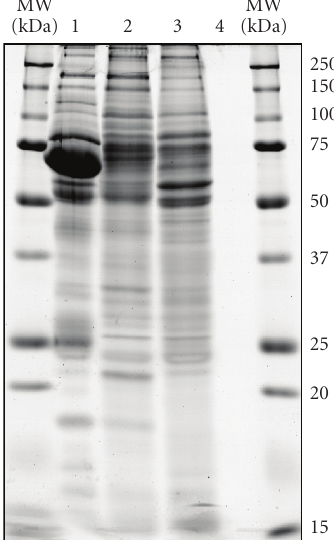
Figure 4: 1DGE analysis of human blood plasma before and after prefractionation using immunoa ffi nity depletion of high-abundant proteins or hexapeptide ligand library treatment. An equal amount of proteins from whole plasma (lane 1), plasma fraction from MARS-Hu 14 (lane 2), plasma fraction from ProteoMiner (lane 3), and potentially remaining proteins from boiled in SDS loading bu ff er ProteoMiner beads after elution (lane 4) were separated on 12.5% SDS-PAGE gel and were stained with Deep